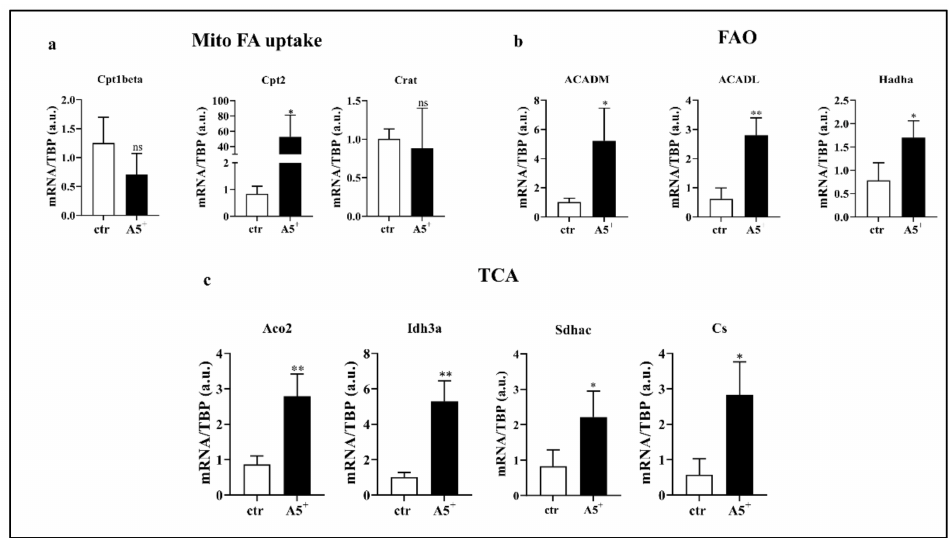
Figure 5. A5 + -induced lipid metabolism. Bar graph illustrating the most relevant lipid metabolism- related genes modulated by A5 + administration: ( a ) Genes related to mitochondrial fatty acids (FA) uptake, ( b ) Genes involved in fatty acid oxidation (FAO), ( c ) Genes regulating tricarboxylic acid (TCA) cycle. Data are reported as mean ± SEM ( n = 4). (* p < 0.05; ** p < 0.005; ns: not